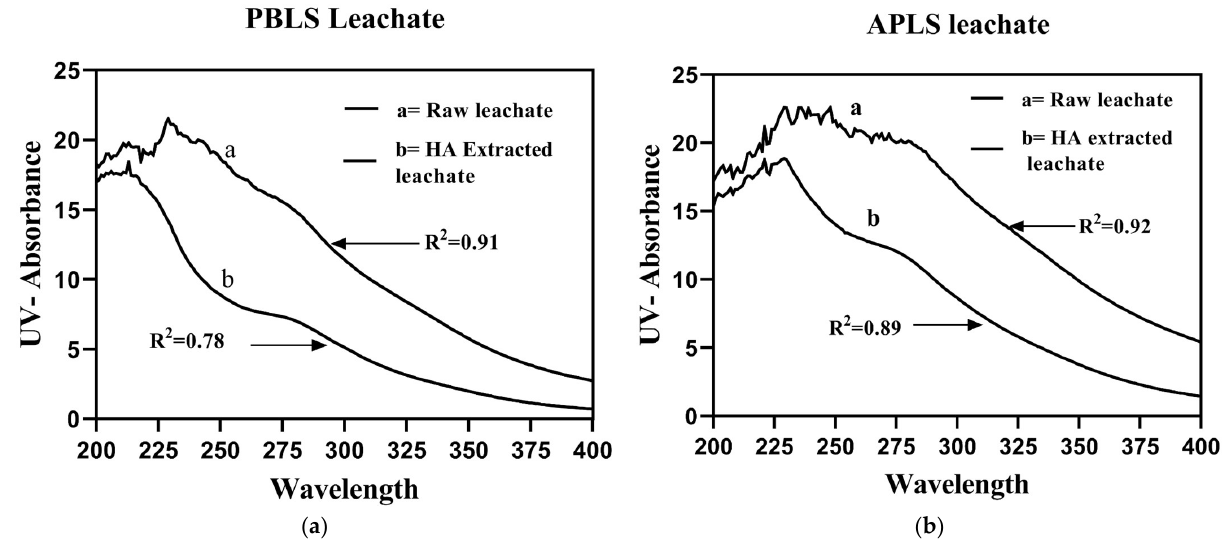
Table 2. Outcomes of UV–Vis absorbance analysis.